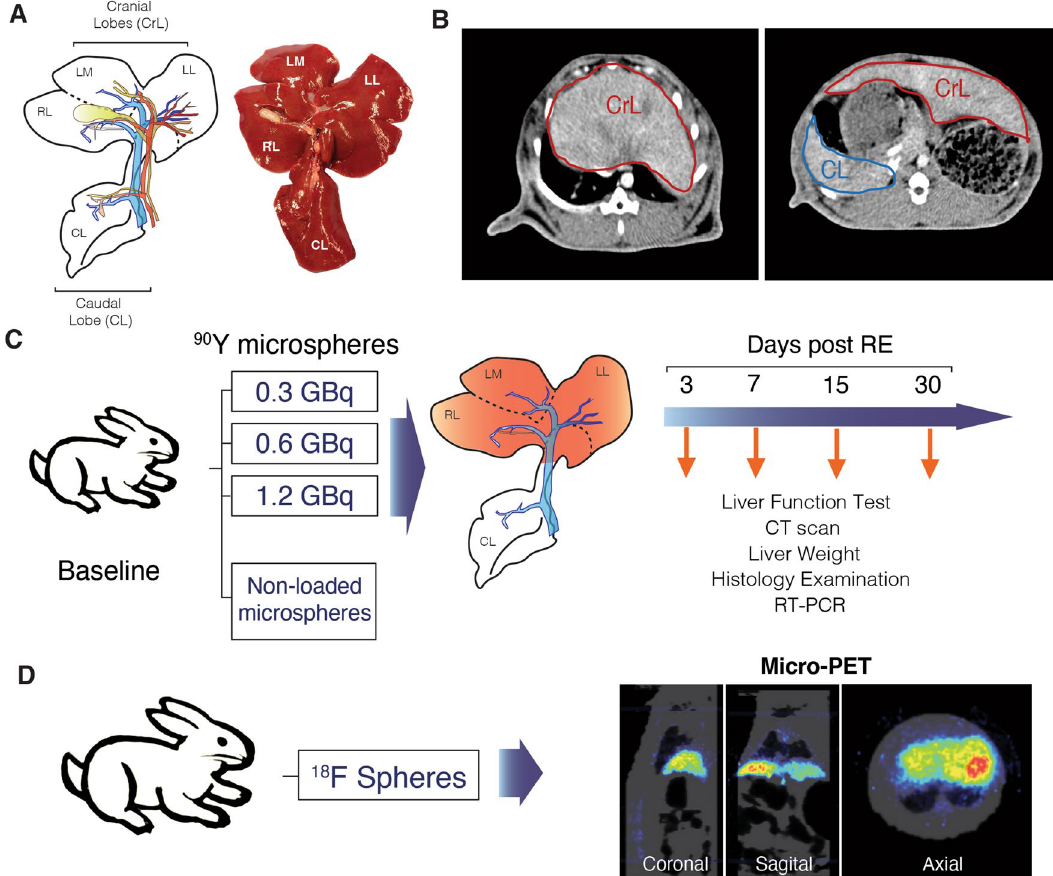
Figure 1. Experimental design. ( A ) Liver anatomy of the rabbit, subdivided into four main lobes. These are the caudal lobe (CL) and three cranial lobes (CrLs): the right (RL), medial left (LM) and lateral (LL) left lobes, each supplied by branches of the arterial and portal venous system. This figure is reprinted from J. Surg. Res. 2011;171:486–94 19 , with permission from Elsevier. ( B ) Axial view of a contrast enhanced CT performed in a rabbit. Manual delineation of CrLs and CL for volumetry quantification. ( C ) Experimental design. Four experimental groups of animals were treated with 90 Y-microspheres or non-loaded microspheres.